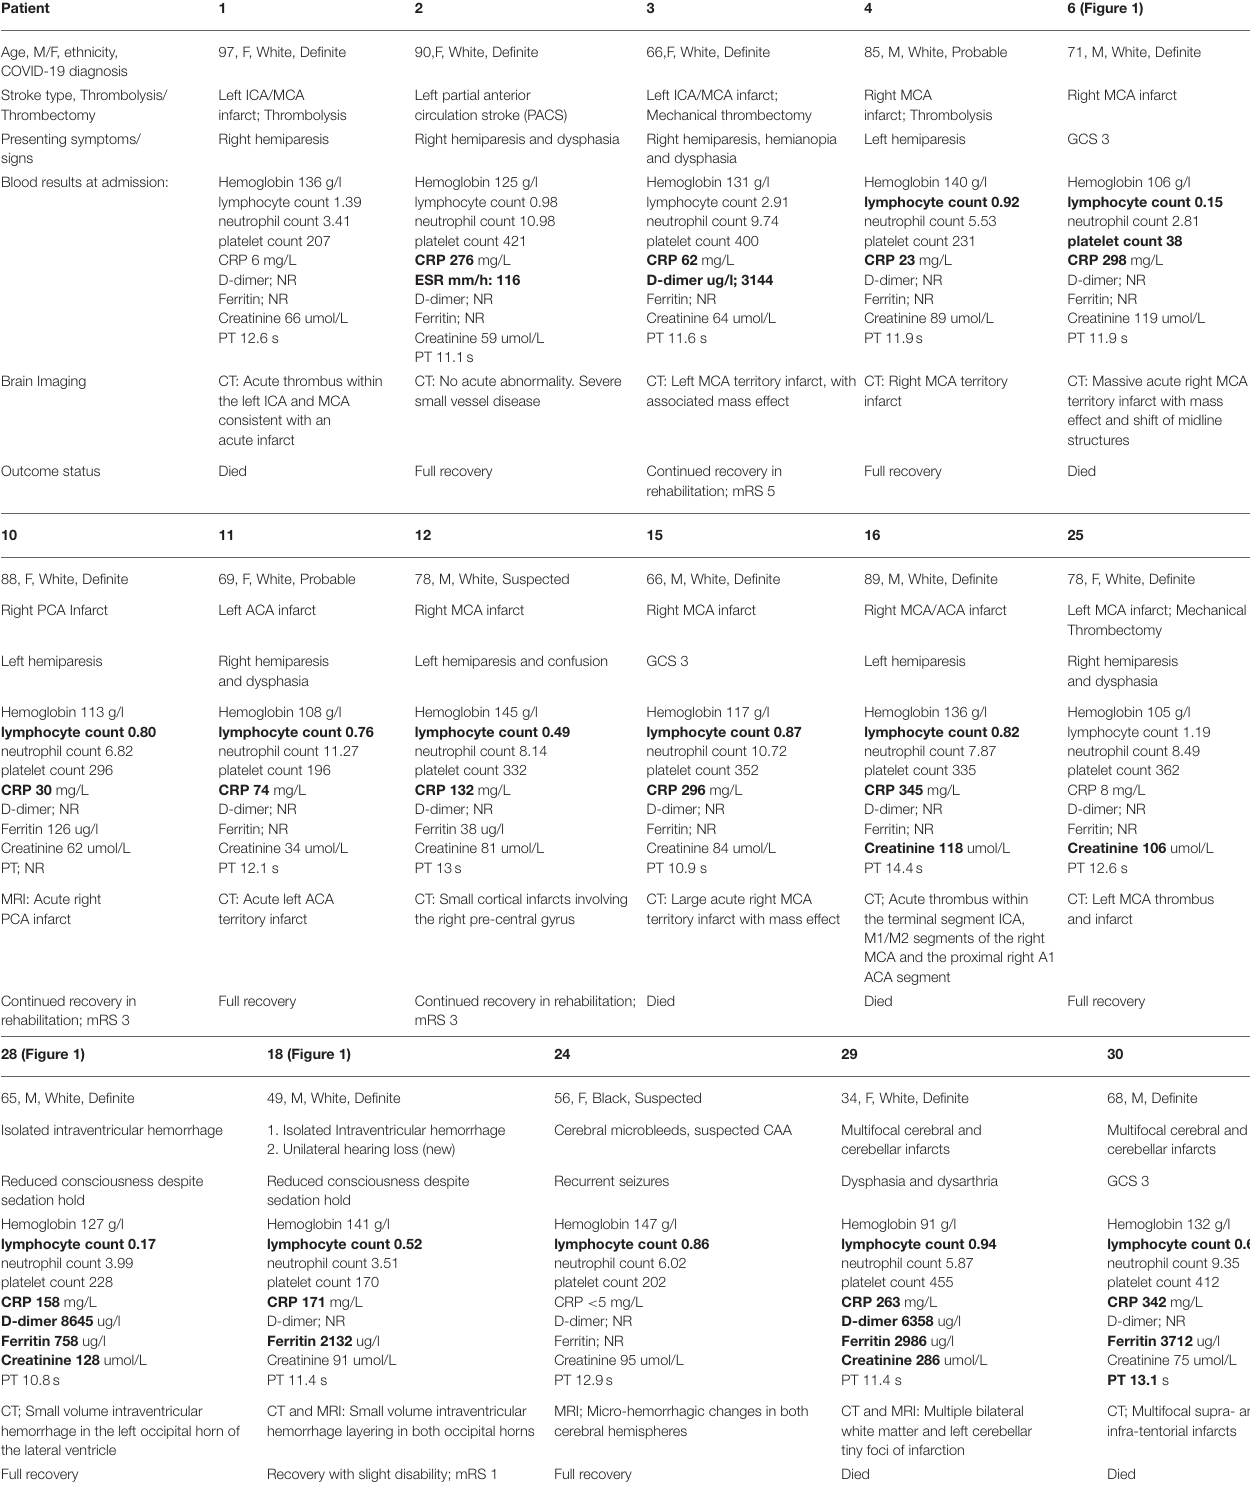
TABLE 1 | Sixteen patients with cerebrovascular events (13 Ischaemic stroke and 3 Hemorrhagic).